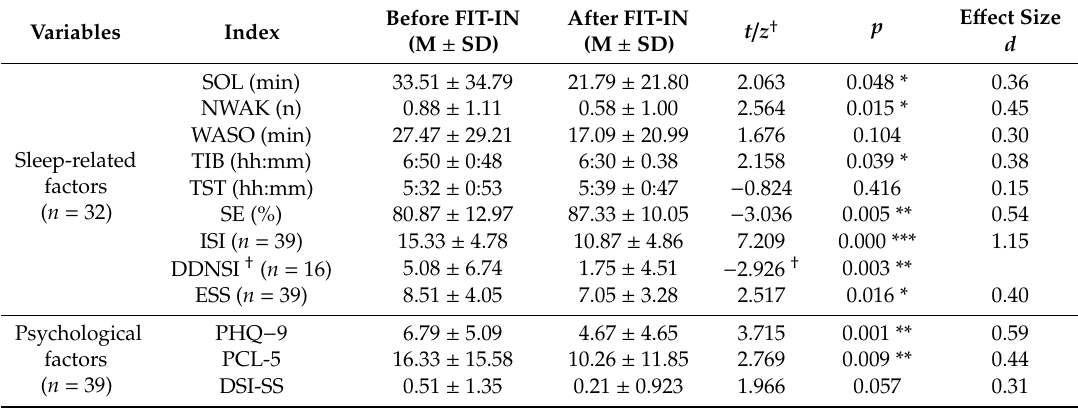
Table 3. The di ff erence of indices between before and after FIT-IN ( n =